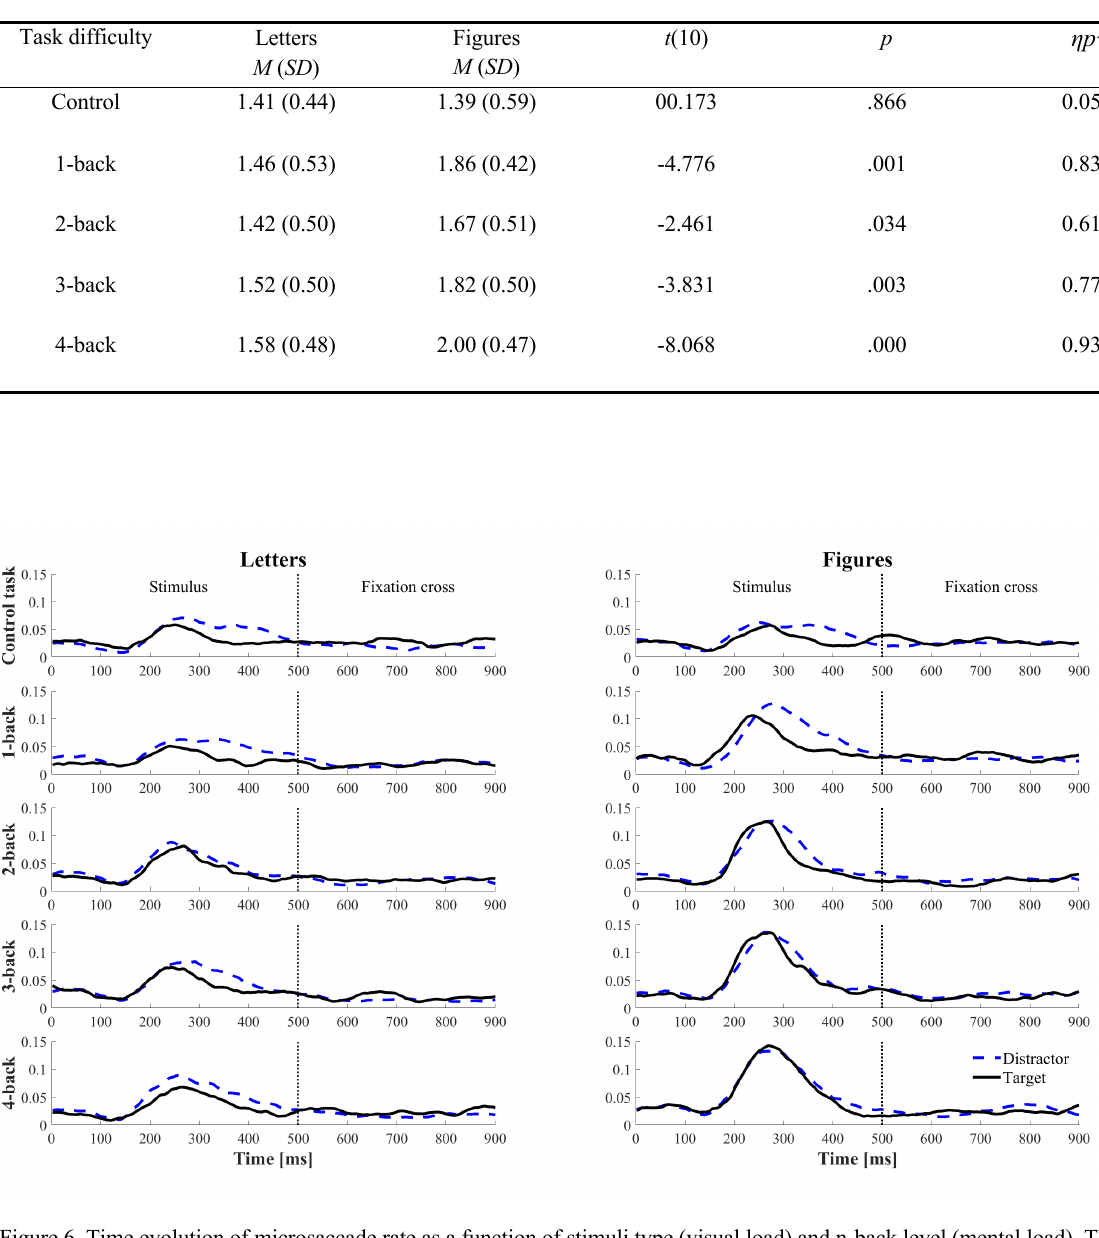
Figure 6. Time evolution of microsaccade rate as a function of stimuli type (visual load) and n-back level (mental load). The blue dashed line represents the microsaccade rate for the distractors and the solid black line the microsaccade rate for the target stimuli (which required an answer from the